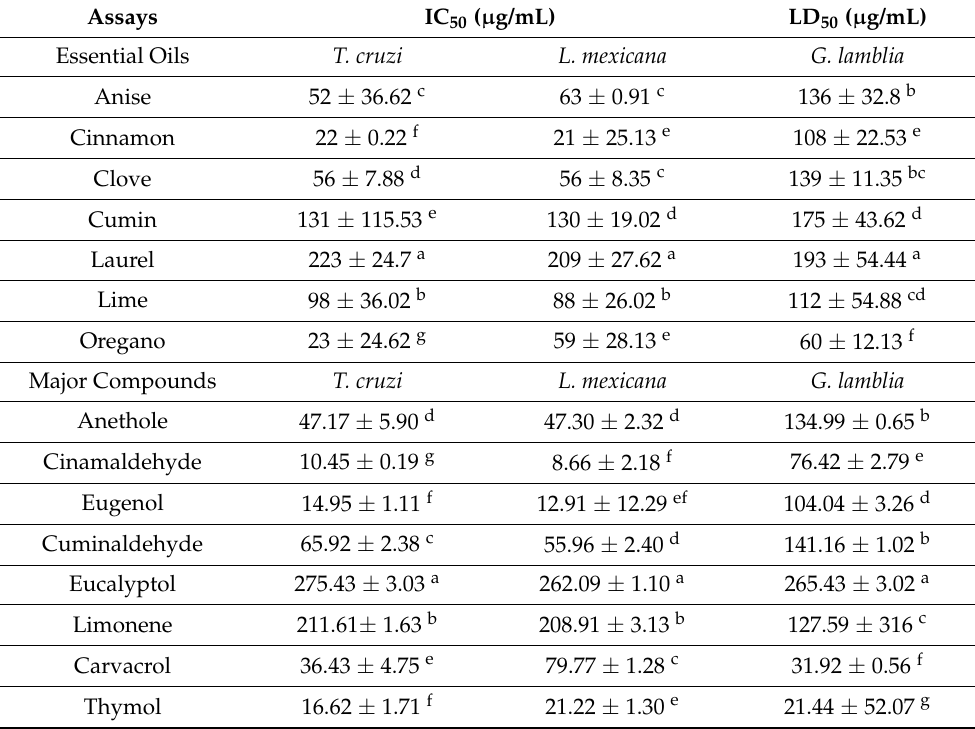
Table 4. Antiprotozoan activity of essential oils and their majority compounds. Assays IC 50 ( µ g/mL) Essential Oils